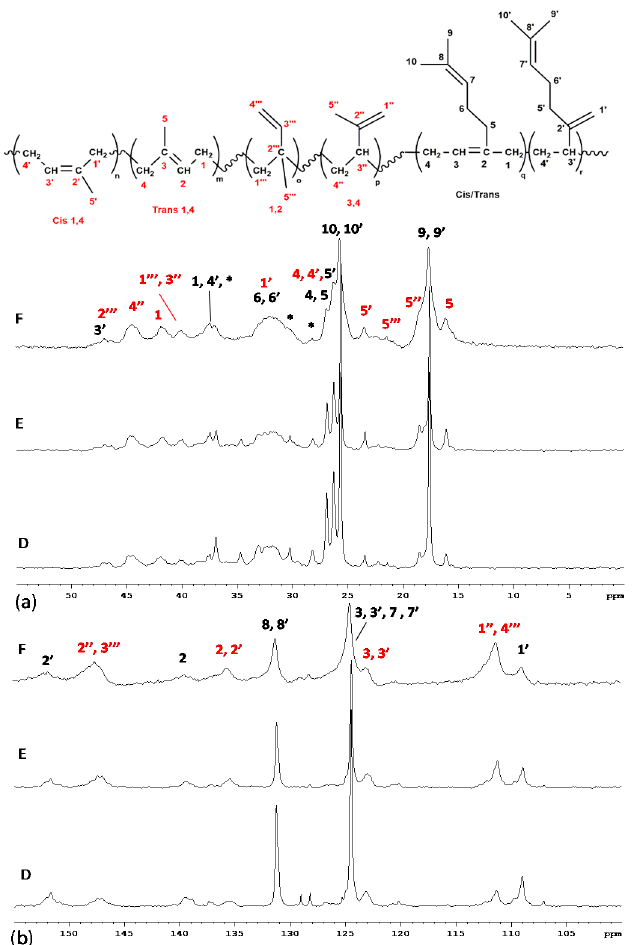
Figure 4. Aliphatic ( a ) and olefinic ( b ) regions of 13 C NMR spectra (TCDE, 25 °C, 400 Mhz) of PMI, synthesized at different myrcene:isoprene ratios. D) M:I (mol/mol) = 70:30 (run 15, Table 2); E) M:I (mol/mol) = 50:50 (run 16, Table 2); F) M:I (mol/mol) = 30:70 (run 17, Table 2). * Signals attributed to head-to-head and tail-to-tail regio-irregular 1,4 M